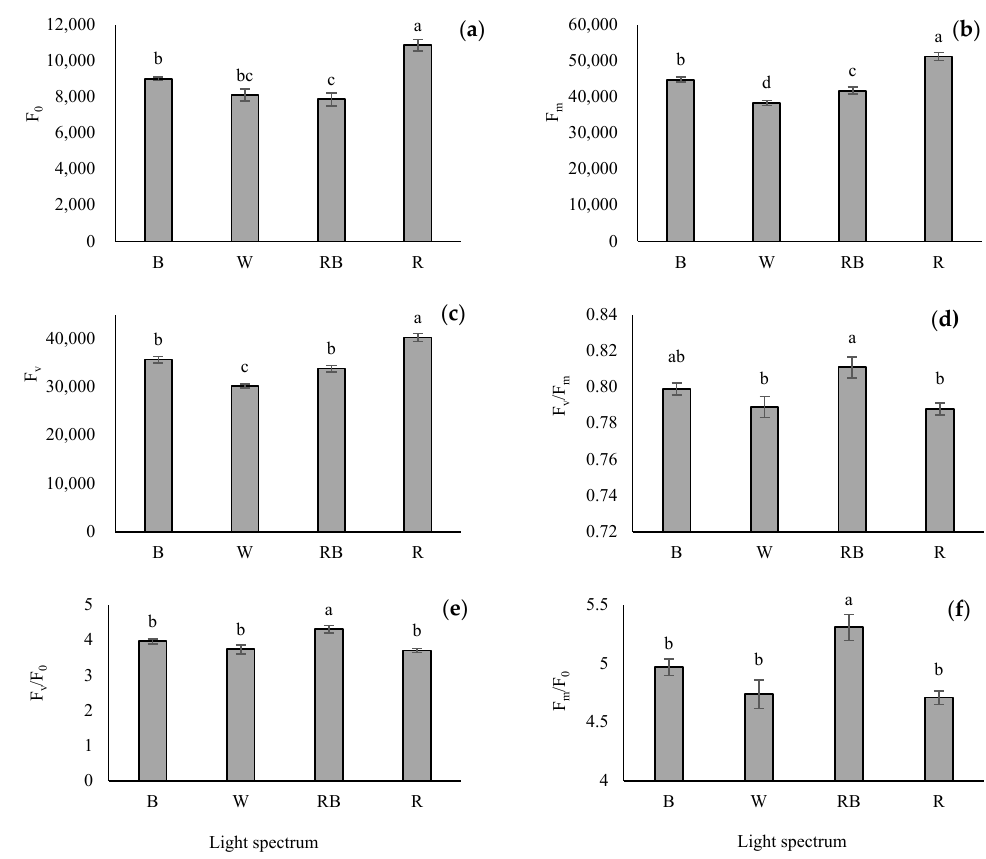
Figure 4. The intensity of chlorophyll fluorescence in the OJIP-test including minimum fluorescence when all PS Π reaction centers are open (F 0 ; ( a )), maximum fluorescence when all PS Π reaction centers are closed (F m ; ( b )), variable fluorescence of the dark-adapted leaf (F v ; ( c )), the maximal quantum yield of PS Π photochemistry (F v /F m ; ( d )), F v /F 0 ( e ) and F m /F 0 ( f ) from the fluorescence transient exhibited by leaves sampled from grafted tomato seedlings exposed to different light qualities (including white (W; 35% B, 49% intermediate spectra, 16% R) light as control, blue (B), red (R), and a combination of red (68%) and blue (RB), (see the correspondence spectrum in Figure 1)), with 75 ± 5 µ mol m − 2 s − 1 PPFD for 20 days. Columns with the same letters are not significantly different at p ≤ 0.05, according to Duncan’s multiple range tests. Bars represent the mean value of three replications ± SEM.